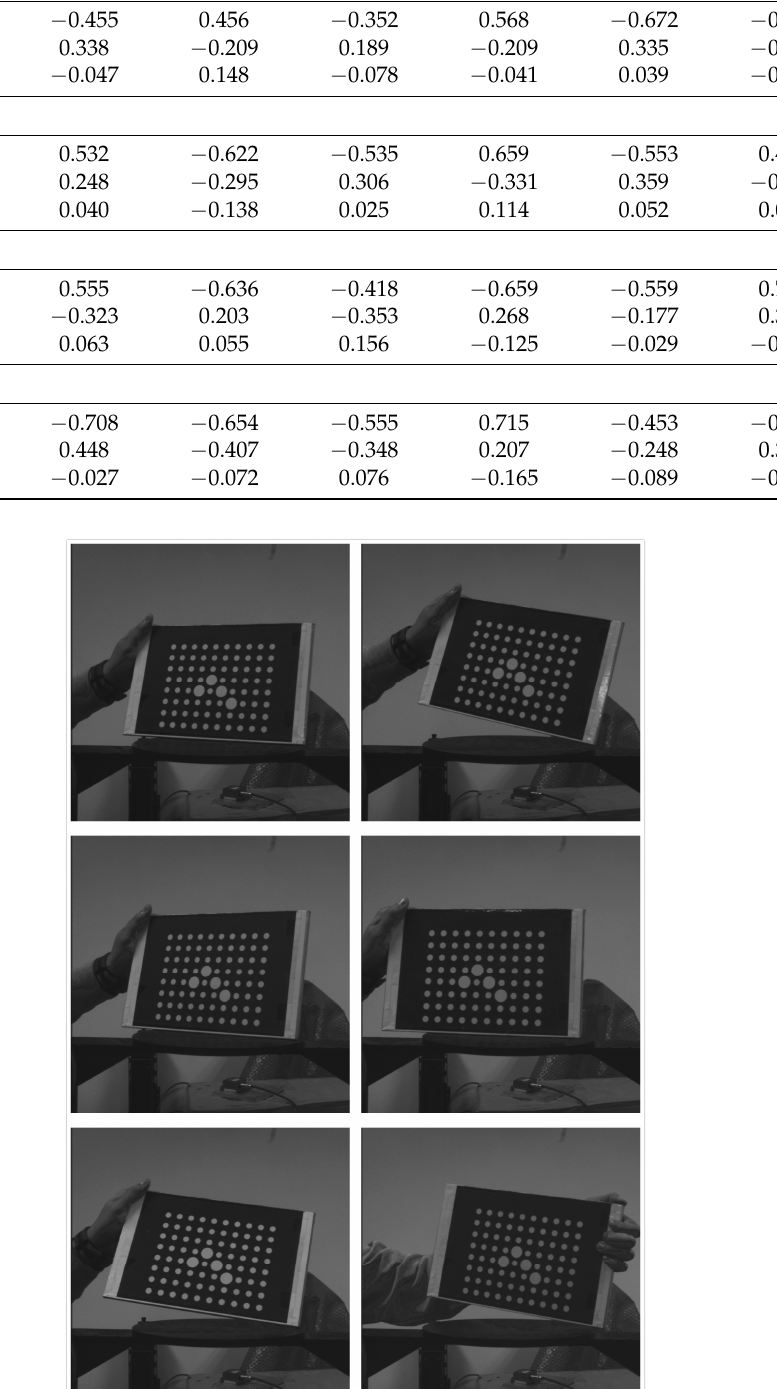
Figure 9. The image sets of the calibration board.